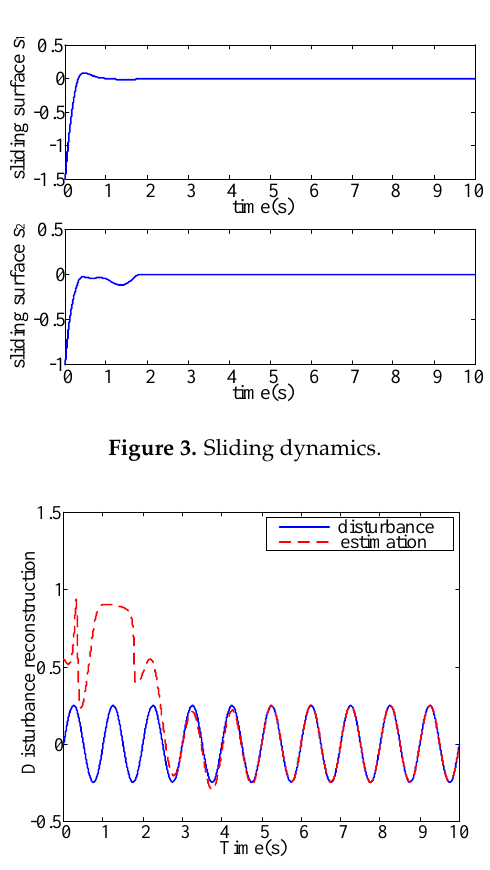
Figure 2. Estimation error responses by SMO.